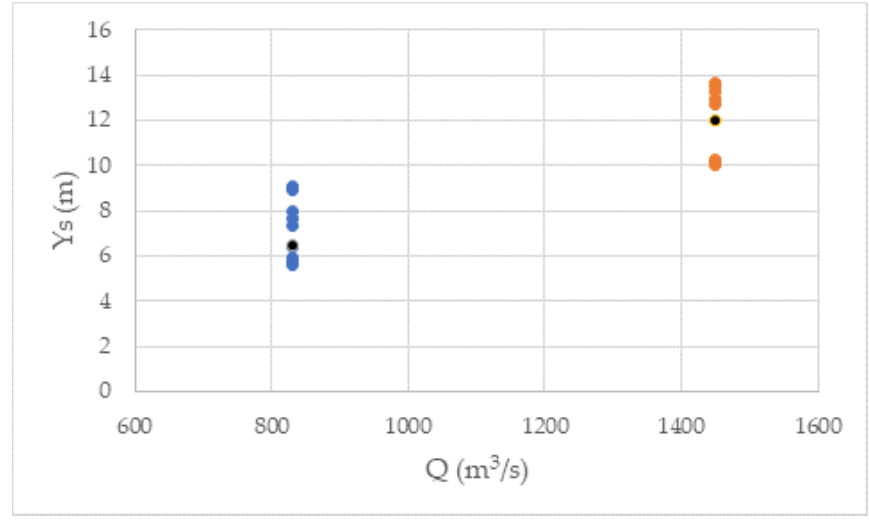
Figure 13. Scour calculated with (2) for discharge set to 830 m 3 /s and 1450 m 3 /s. Water 2020 , 12 , x FOR PEER REVIEW